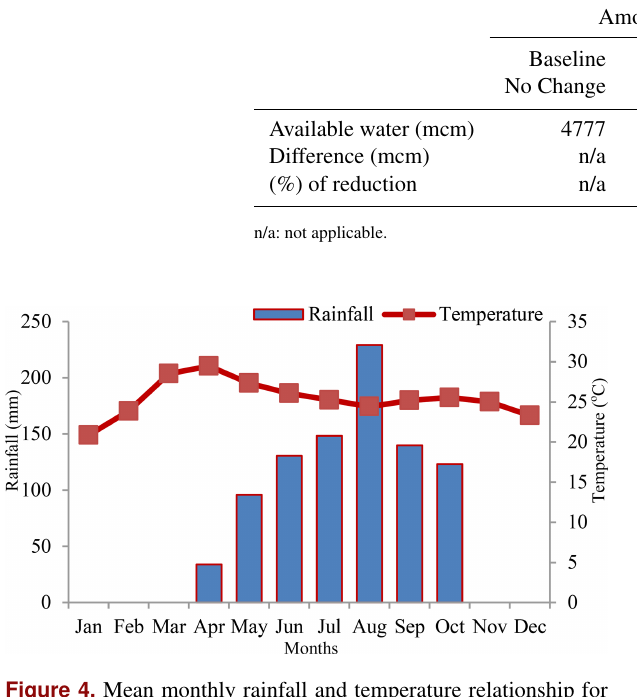
Figure 4. Mean monthly rainfall and temperature relationship for scenario 2 from 1988 to 2019 in GRC.